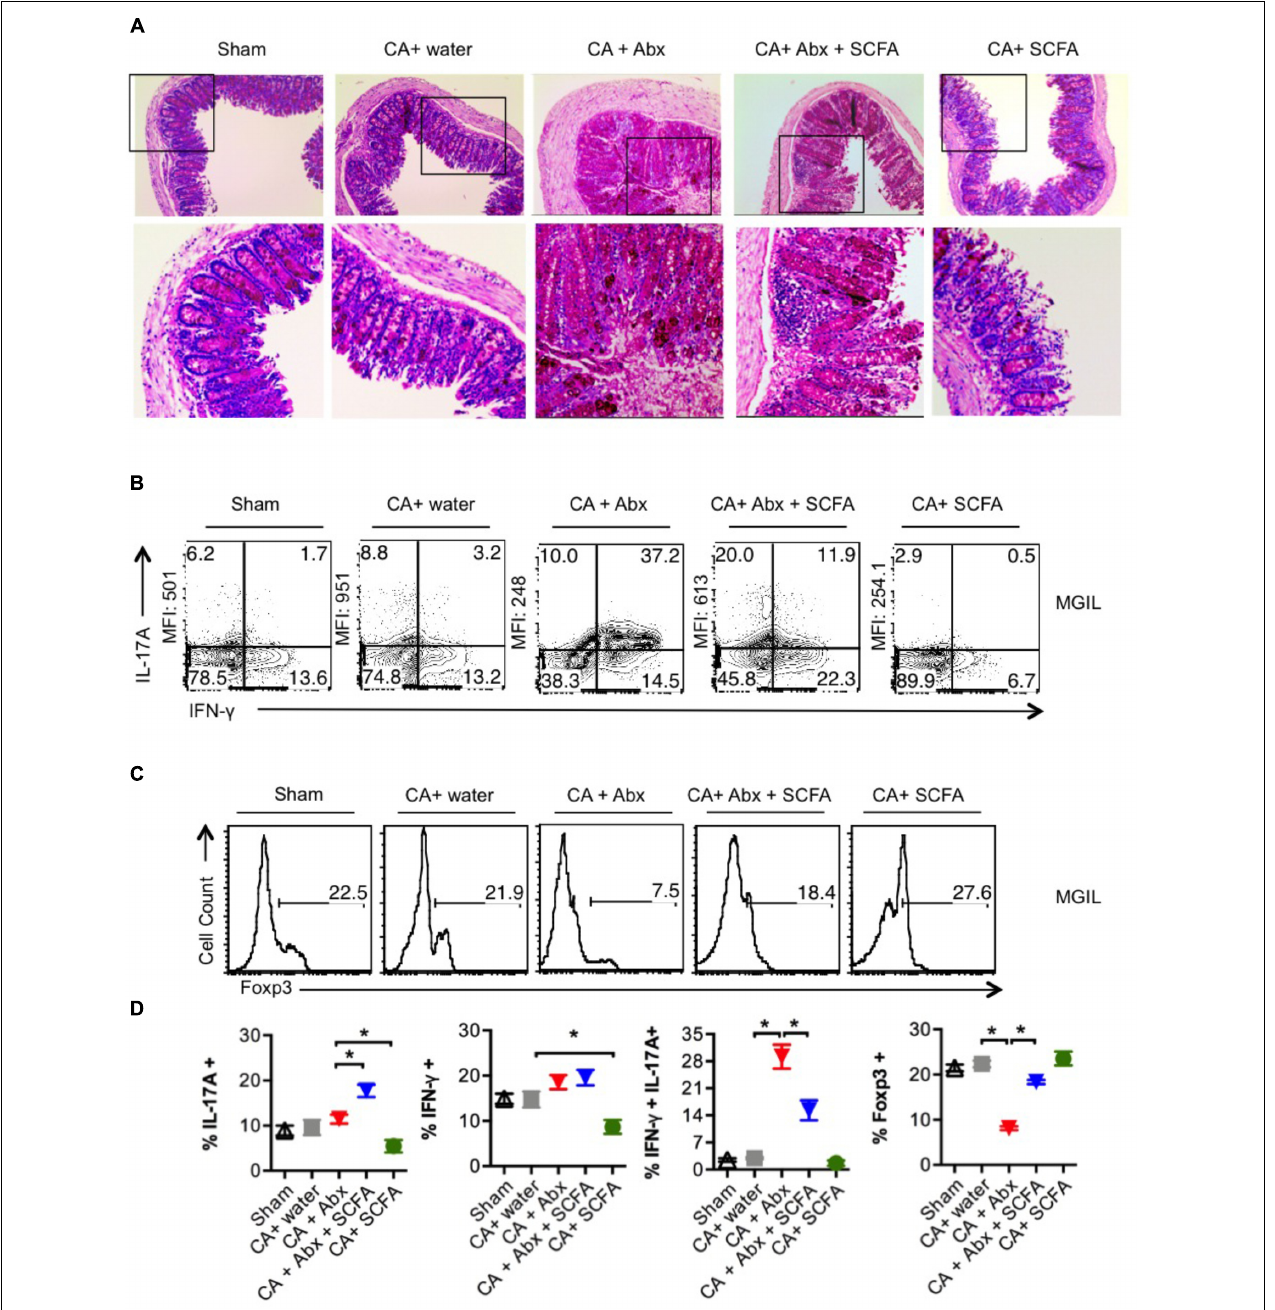
FIGURE 3 | Abx treatment induces colon inflammation during OPC in mice, while SCFAs partially reduce immunopathology. (A) Three days after 2nd re-infection, we isolated and fixed colon tissues and performed PAS staining and histo-pathological examination using microscopy (200 × magnification). (B,C) One day after second re-infection, MGIL were isolated from colon and re-stimulated as in Figure 2 . Flow cytometric contour plots show the expression of IFN- γ and IL-17A (B ), and Foxp3 (C) . Mean fluorescent intensities (MFI) of IL-17A expression are shown on the “Y- axes.” (D) Statistical analyses for % cytokine + cells or % Foxp3+ in MGIL ( n = 4/group) was performed using Mann–Whitney test ( ∗ P < 0.05). Mean ± SEM are shown. At least three independent experiments showed similar